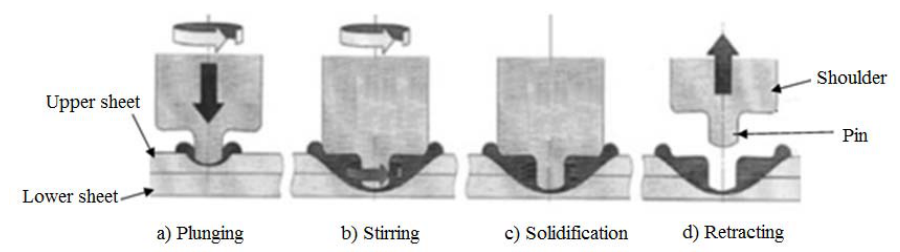
Figure 1: Friction stir spot welding process [32].